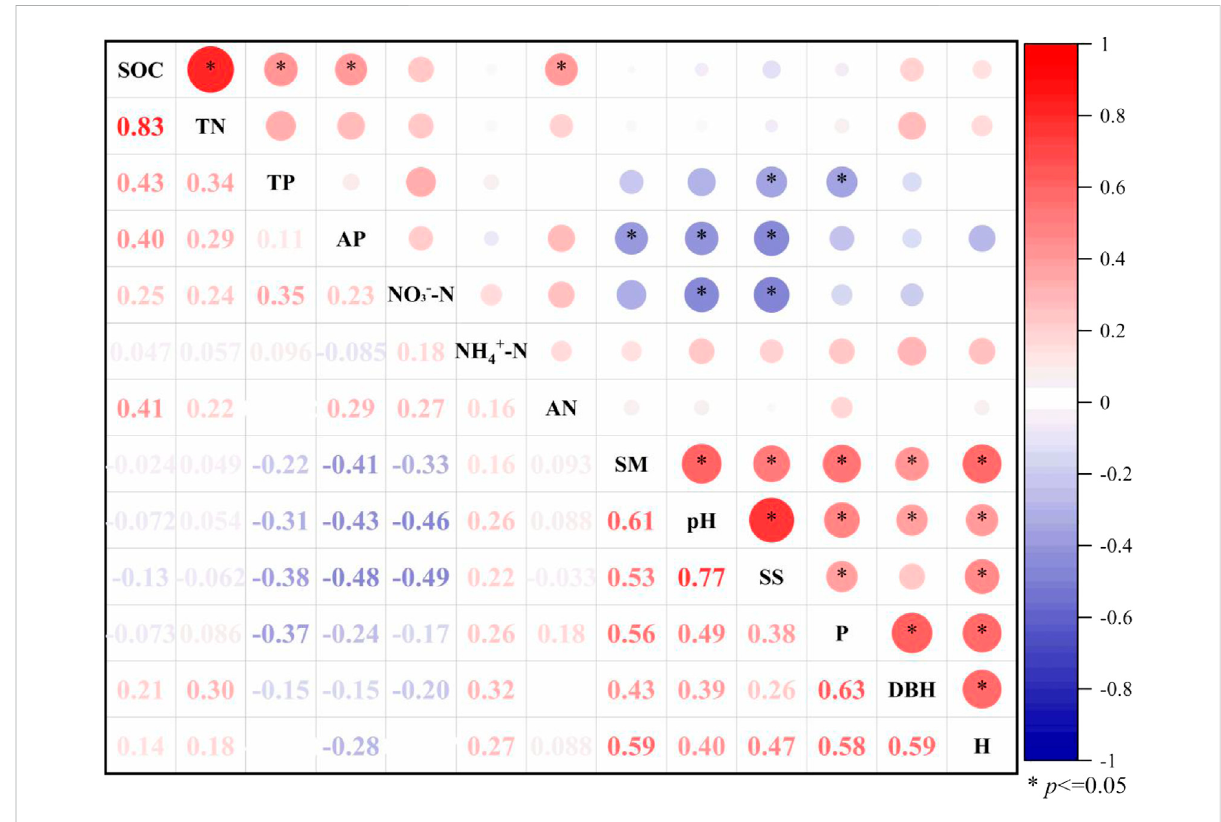
FIGURE 1 Correlation analysis of factors that in fl uence the ‘ fertilizer island ’ effect of different nutrient contents in Populus euphratica. Note: SM, soil moisture content; SS, soil salinity; pH, soil pH; P, plant crown width; DBH, plant diameter; and H, plant height (consistent in Figures 2,